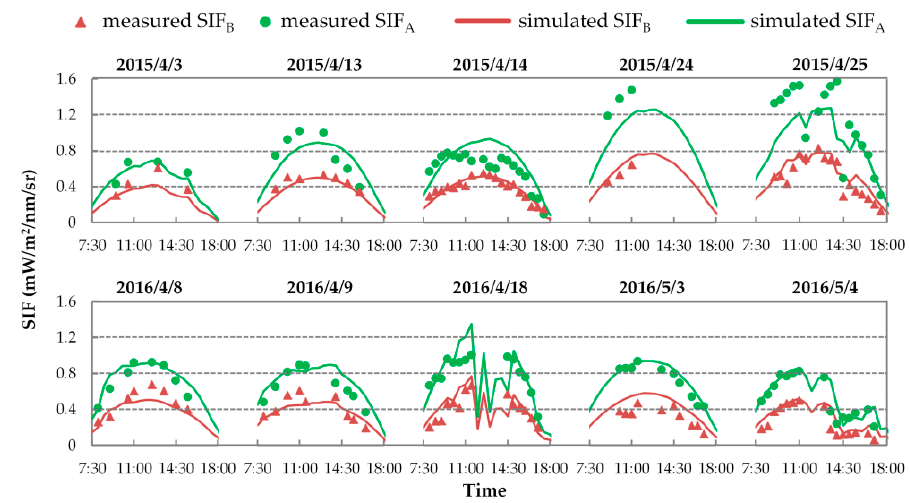
Figure 9. The diurnal cycles of simulated SIF with fixed FQE, compared to the measured SIF at O 2 -B and O 2 -A bands on ten fieldwork days in 2015 and